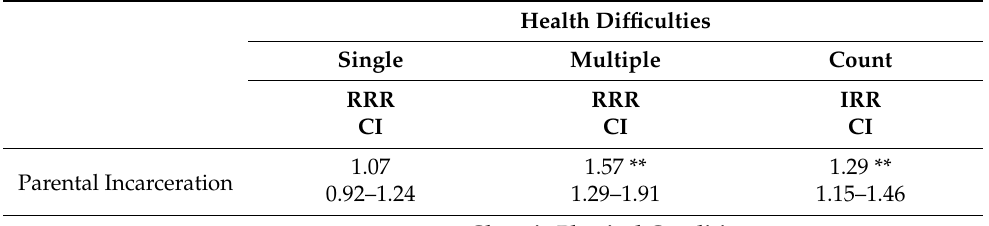
Table 2. The Link between Parental Incarceration and Child Health: The National Survey of Chil- dren’s Health, 2016–2018 ( N = 102,341). Health Difficulties Single Multiple Count RRR RRR IRR CI CI CI Parental